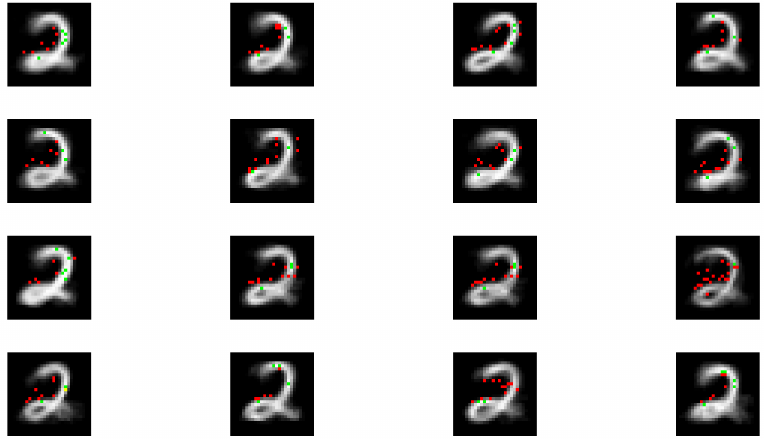
Figure 4. Centroids of 16 rules with their antecedents generated from R 1 in the fully connected layers.